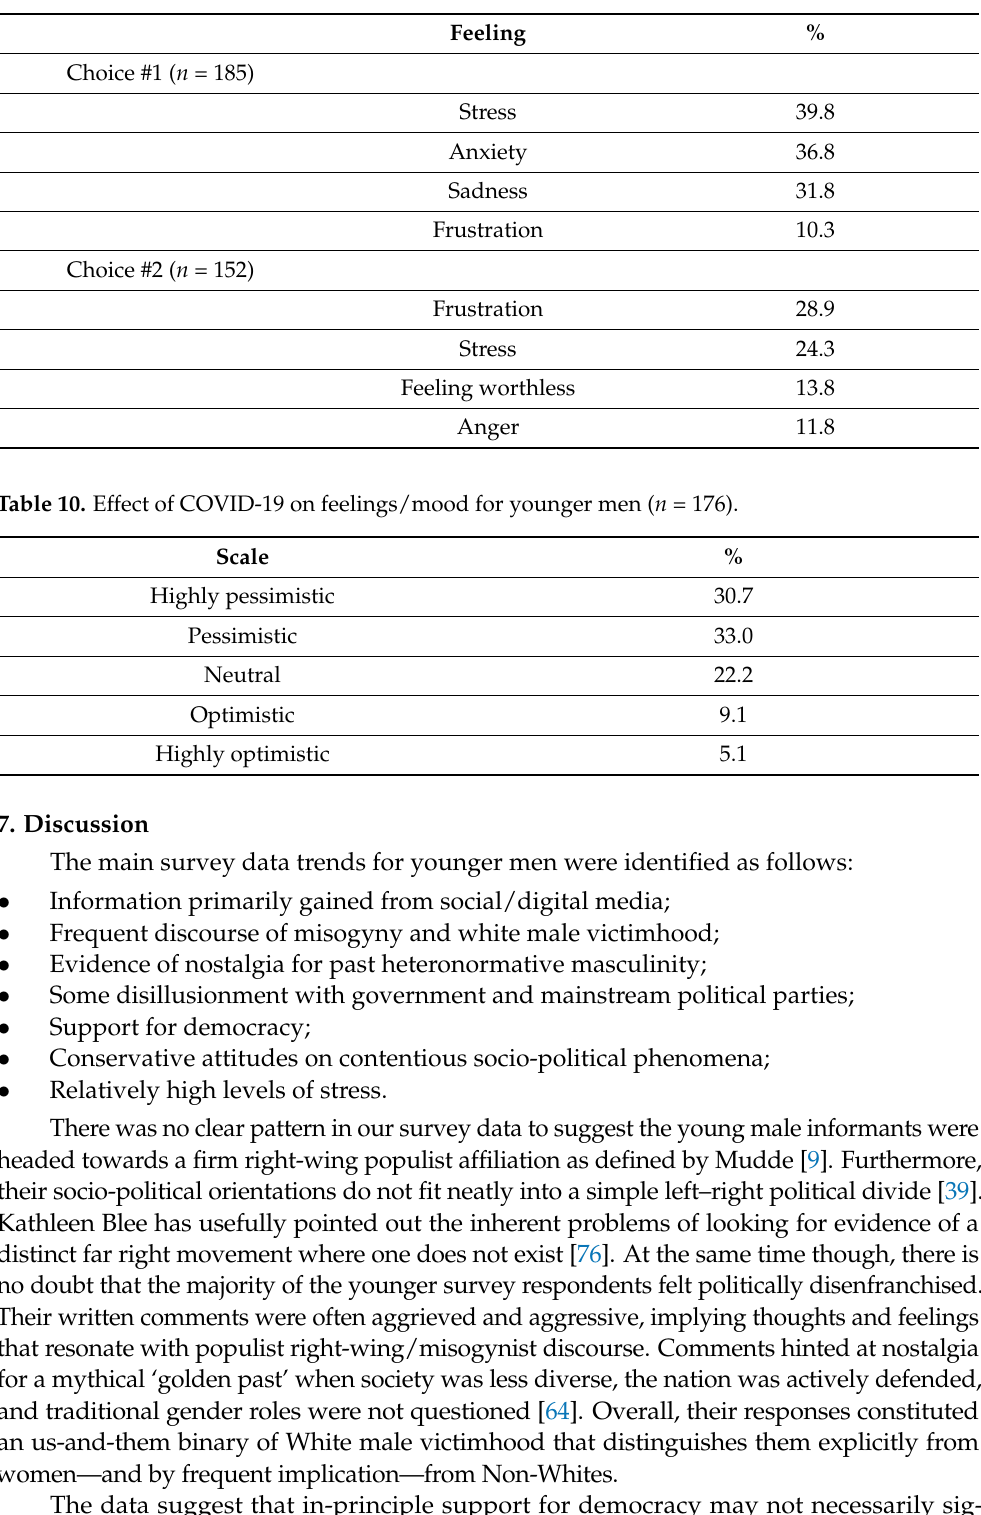
Table 9. Most common feelings for younger men in the past month.